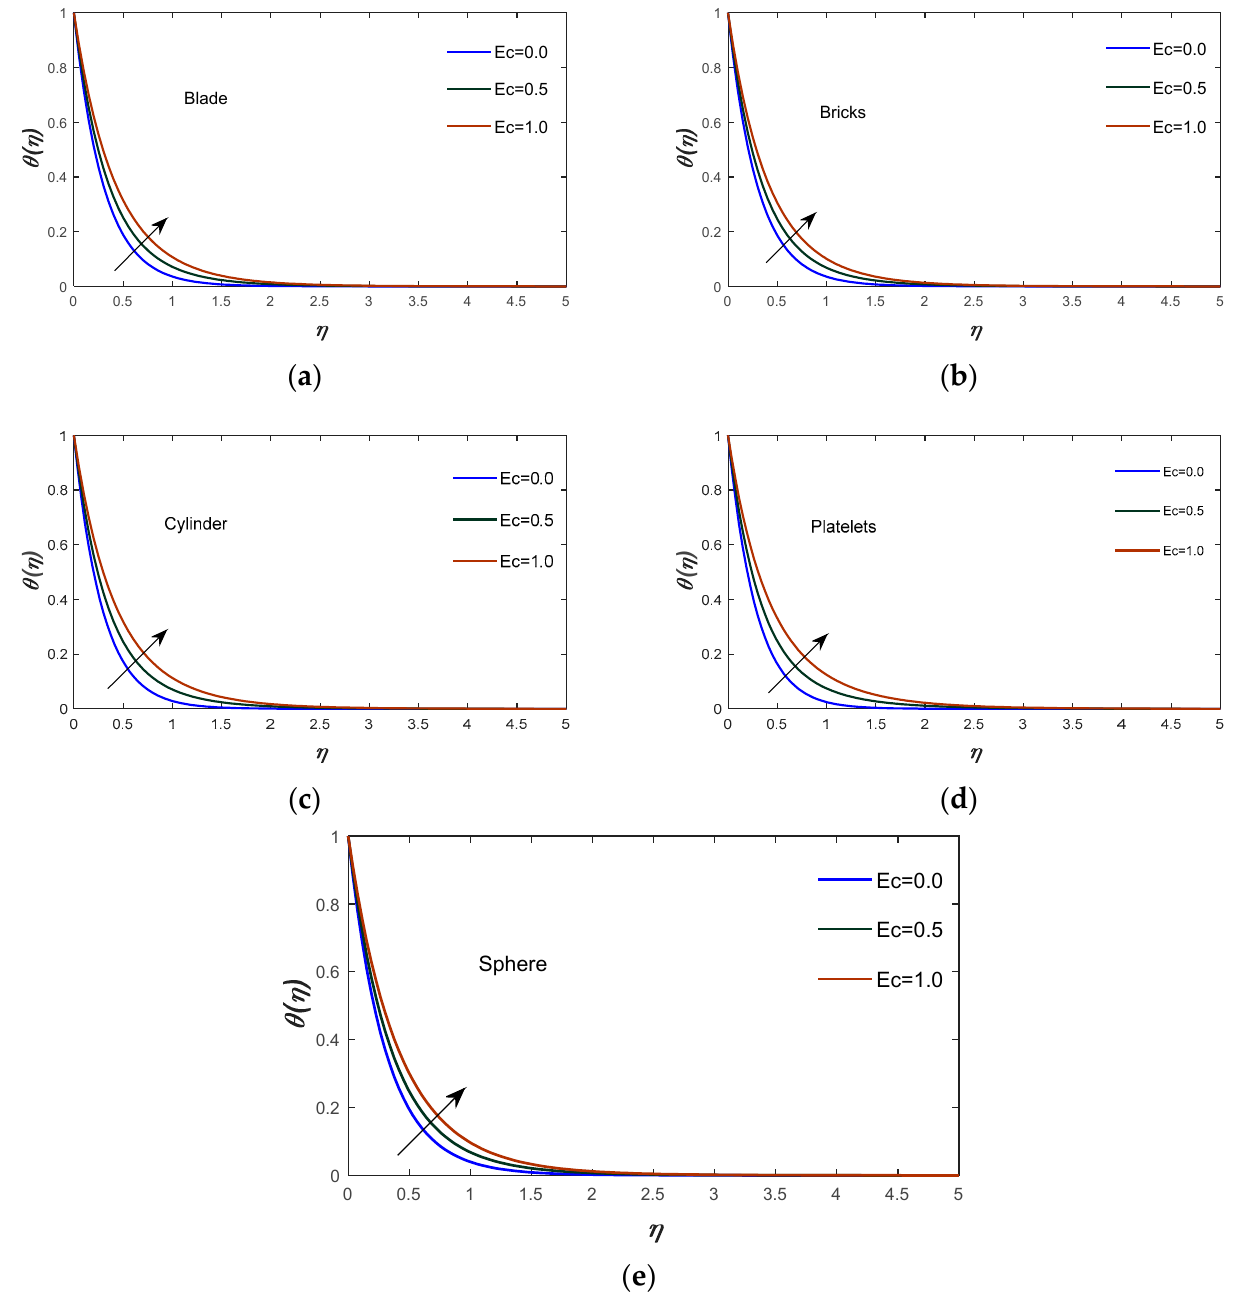
Figure 10. ( a – e ). Impact of 𝑃𝑟 on 𝜃(𝜂) by using various shapes factors of nanoparticles for fixed 𝑀 = 1.0, 𝑃𝑟 = 6.0, 𝑆 = 0.5, 𝑘 = 0.5, 𝜑 = 0.02 .